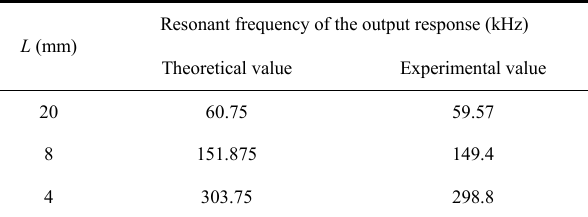
Table 1 Resonant frequency of the output response of the sensors with different L